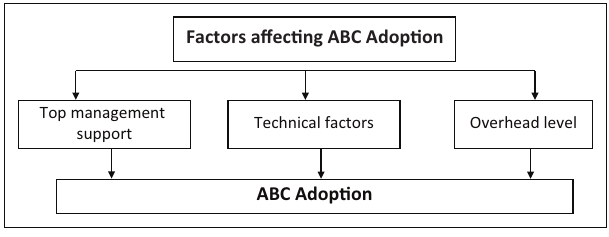
FIGURE 1: Proposed new activity-based costing